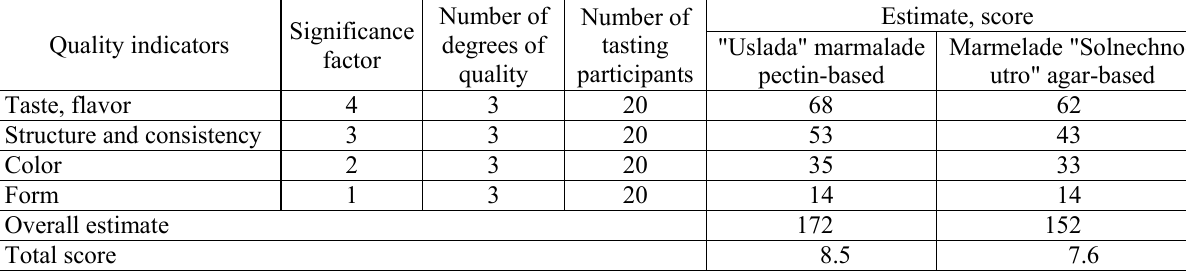
1 Table 6. Results of a scoring of the organoleptic indicators of jelly-fruit marmalade